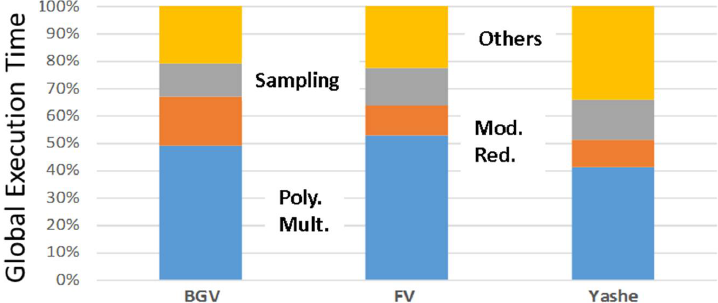
Figure 6. Software implementation profiling of the FHE schemes BGV [21], FV and Yashe [6], showing the impact on execution time of the polynomial multiplication, modular reduction, Gaussian sampling and all other